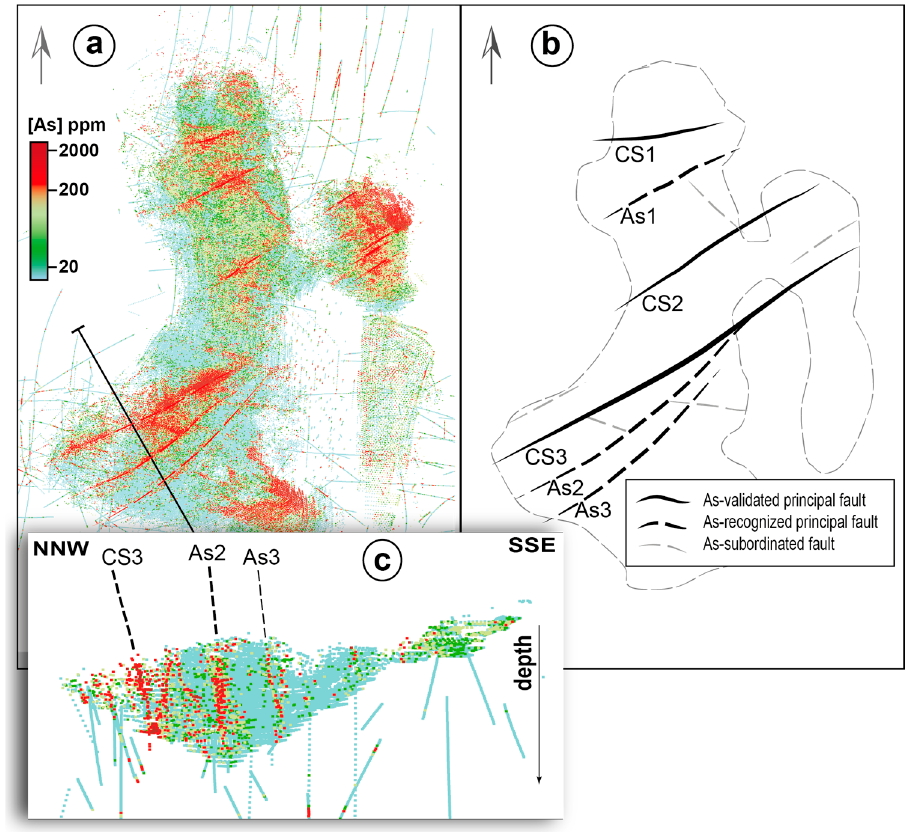
Figure 7. ( a ) Orthographic projection of the spatial distribution of arsenic concentrations from drill-holes (aligned points) and blast-holes (points with a high-density distribution). ( b ) Sketch of orthographic projection showed in ( a ), outlining the previously recognized main faults, three arsenic-denoted new principal faults (labeled as As1, As2, and As3 faults) and some arsenic-denoted subordinated faults. ( c ) A NNW-SSE cross-section showing the geometry of arsenic concentrations in depth. The inset in ( c ) outlines previously recognized and arsenic-denoted main faults. CS: Central System Faults 1, 2 and 3.